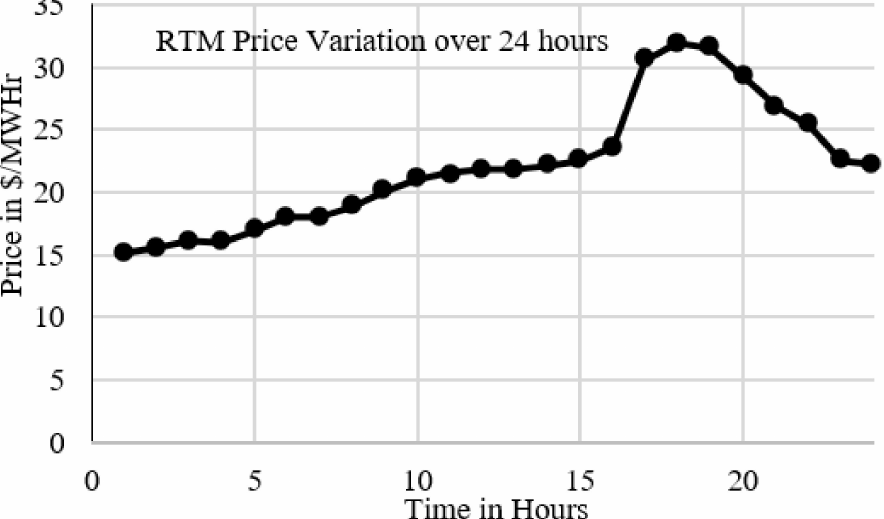
Figure 3. Variation of settlement point price with respect to time in